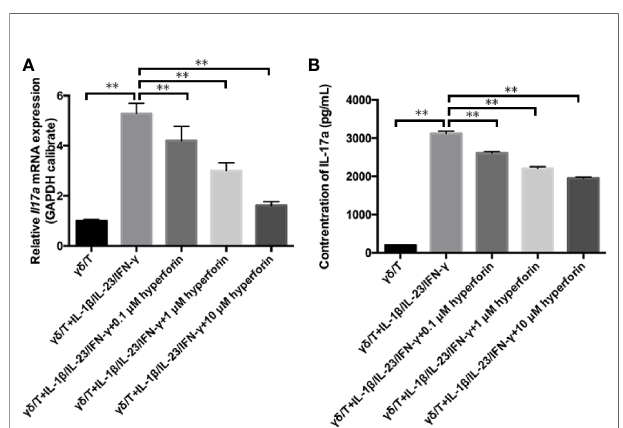
FIGURE 7 | Hyperforin reduced the expression and secretion of IL-17A by gd T cell in vitro . (A) The expression of Il17a mRNA was signi fi cantly lower than that in the model group. (B) The level of IL-17 A in the culture supernatant was measured by ELISA to determine the effects of hyperforin on the secretion of IL-17 A by cultured gd T cells (n=8). **P < 0.01 vs model